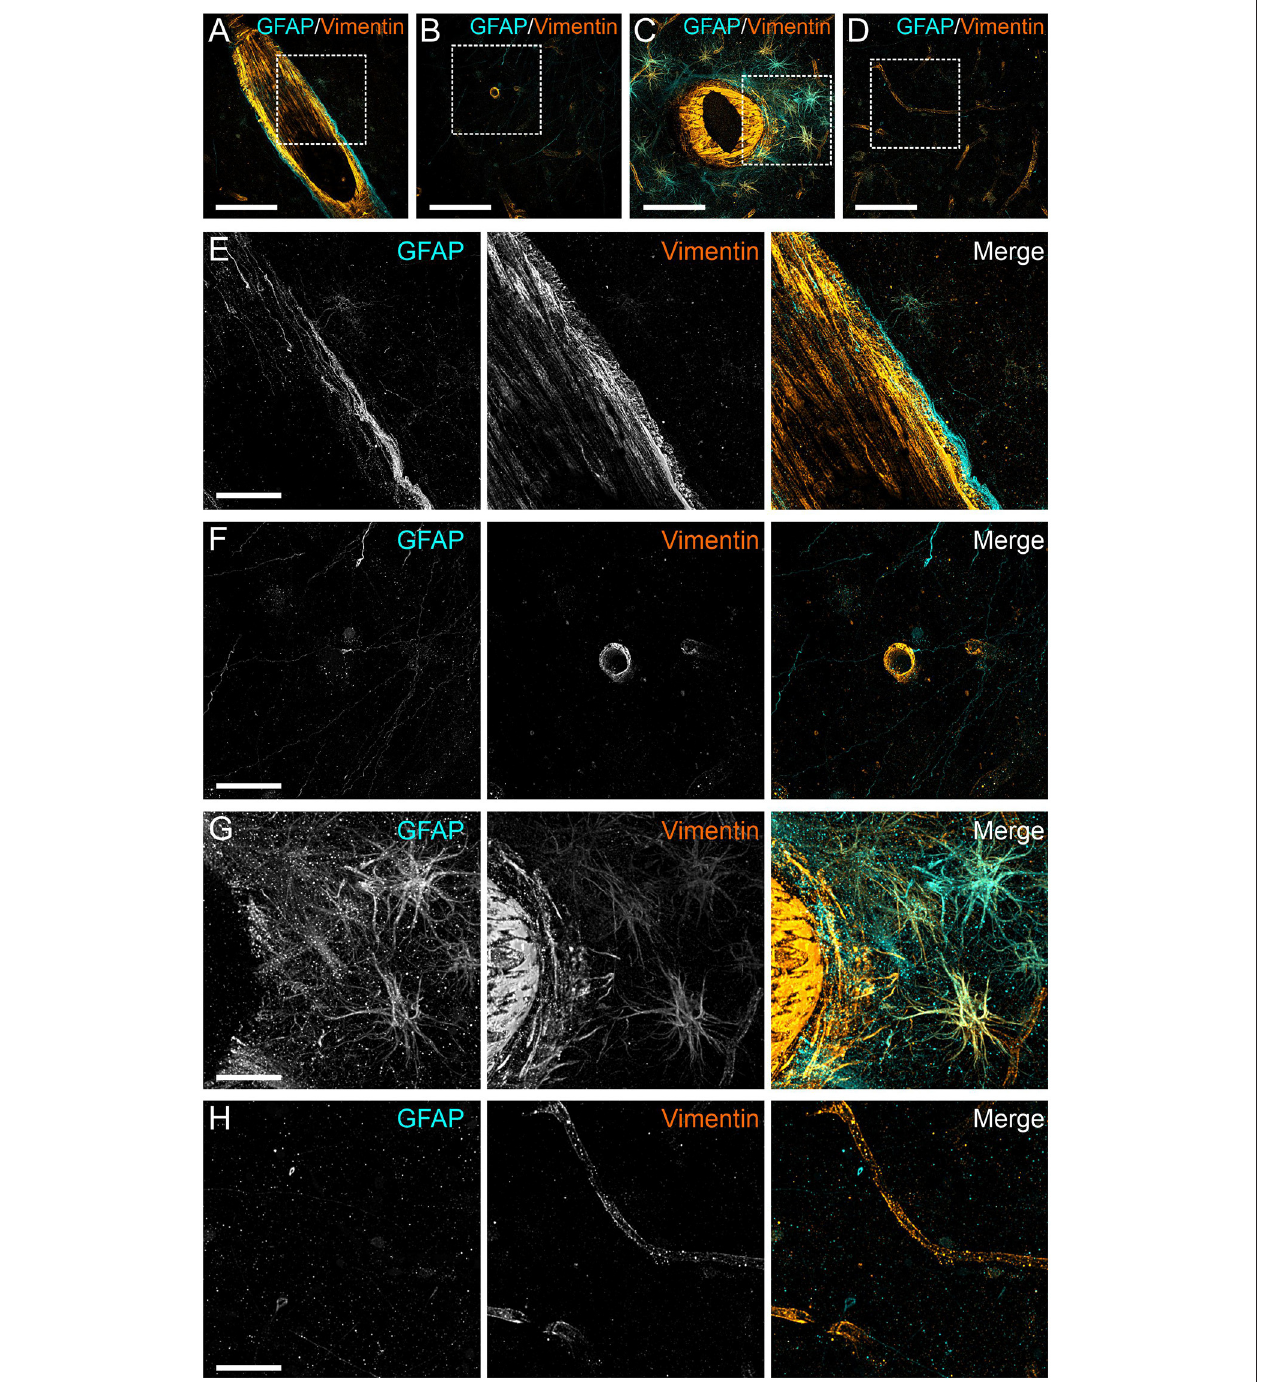
FIGURE 5 | Anti-GFAP and anti-vimentin immunoreactivity of human cortical gray matter in COVID-19 patients. Three-dimensional projection of vimentin (orange) and GFAP (cyan) antibody staining of 250 µ m thick sections of perivascular (A) and parenchymal (B) gray matter of frontal cortex of a young patient with COVID-19 (age 54). Perivascular (C) and parenchymal (D) staining of an elderly patient (age 99). Squares indicate regions depicted in the following images. (E–H) magnified views of the stainings shown in (A–D) . Scale bars: (A–D) , 100 µ m; (E,F) , 30 µ m.